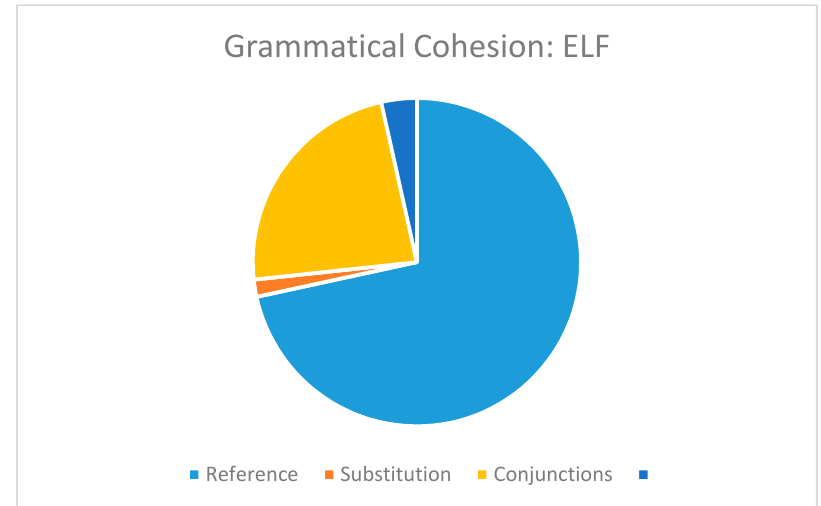
Figure 2. Cohesion in ELF.